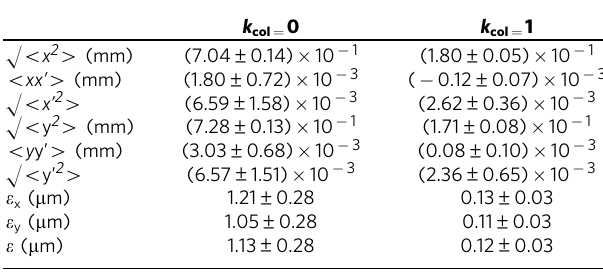
Table 1 | Beam parameters of the double-gate metal nanotip array cathode at the beam waist at L ¼ 0 for k col ¼ 0 (uncollimated) and k col ¼ 1 (collimated) beams with the cathode potential of (cid:2) 20